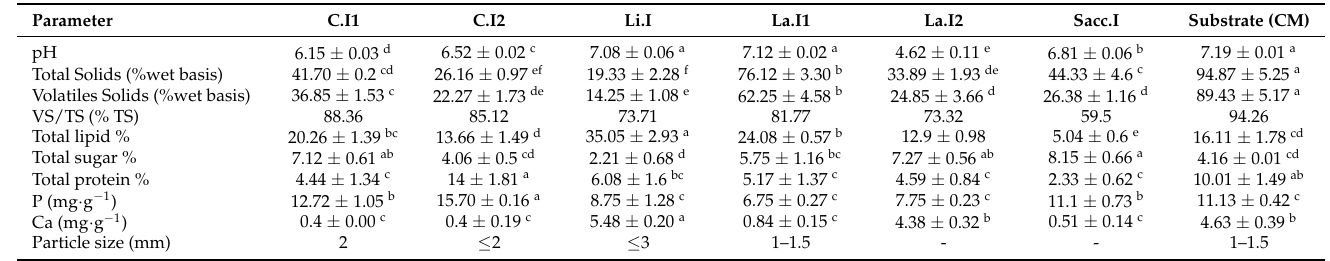
Table 2. Physicochemical and biochemical parameters of inocula and substrate